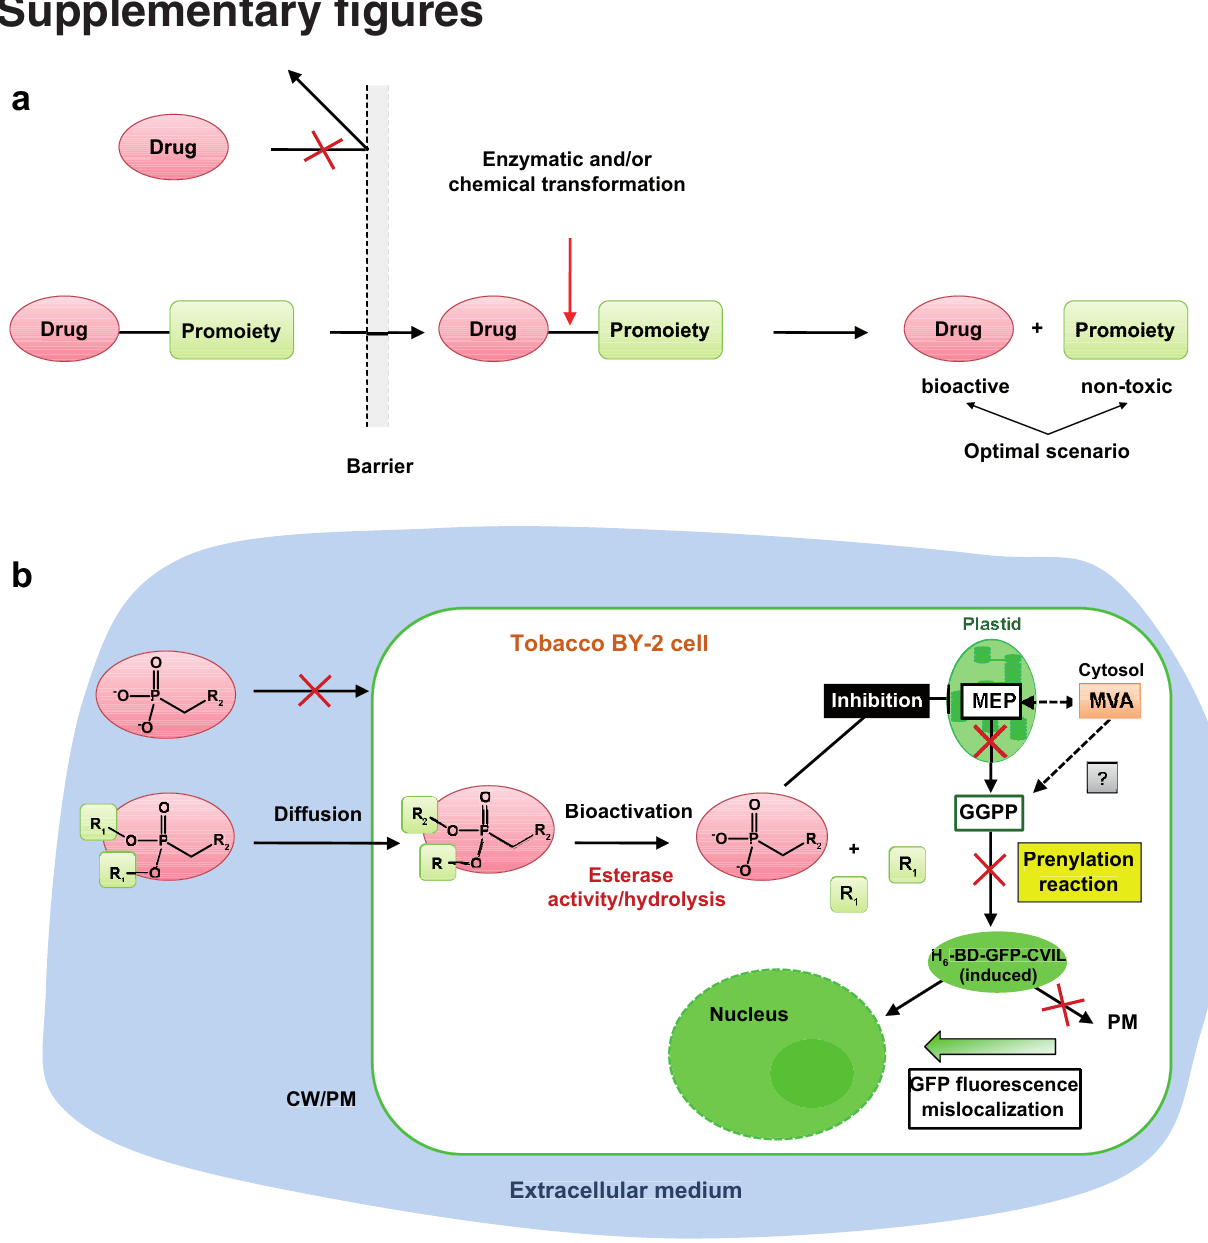
Figure S1. Simplified illustration of the prodrug concept in context with the fluorescent reporter system based on the prenylable and inducible GFP fusion protein H -BD-GFP-CVIL (modified from Rautio et al . 107 ). The prodrug is a chemically modified version of the 6 pharmacological active compound. The addition of a covalently linked “promoiety” masks the parent drug and improves for example